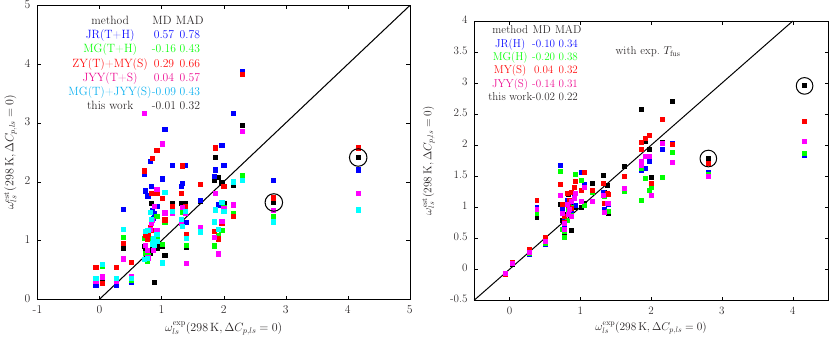
Fig. 6. Estimated vs. experimental ω ls at 298 K, assuming ∆ C p,ls =0 . Left: fully estimated. Right: using the experimental T fus , with ∆ H fus or ∆ S fus estimated. The MD and MAD of the methods are also given. The 1:1 diagonal is indicated (black line). The two most important outliers of the new method are indicated by a circle (from small to high experimental ω ls : oxosuccinic acid, tartaric acid).